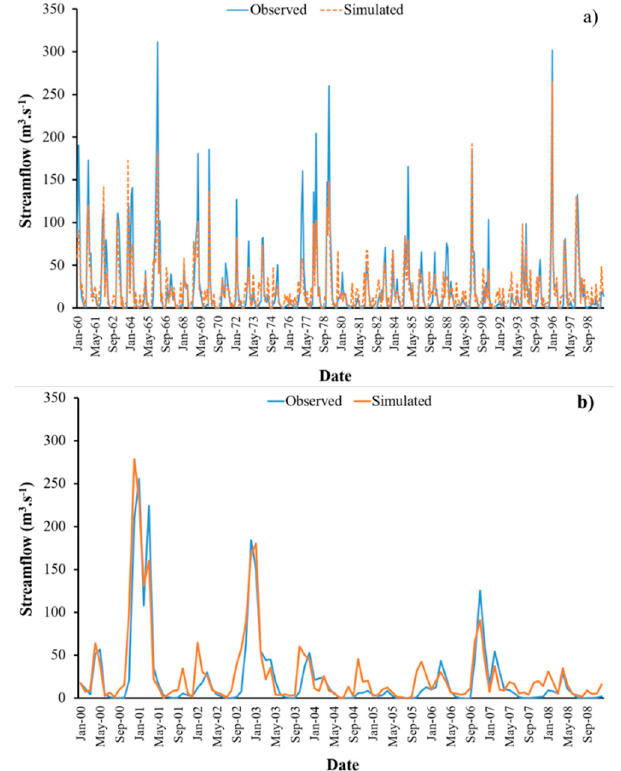
Figure 5. Comparison of observed and simulated streamflow during ( a ) the calibration period (1960–1999); and ( b ) the validation period (2000–2008) in the Sabor River basin. The simulation